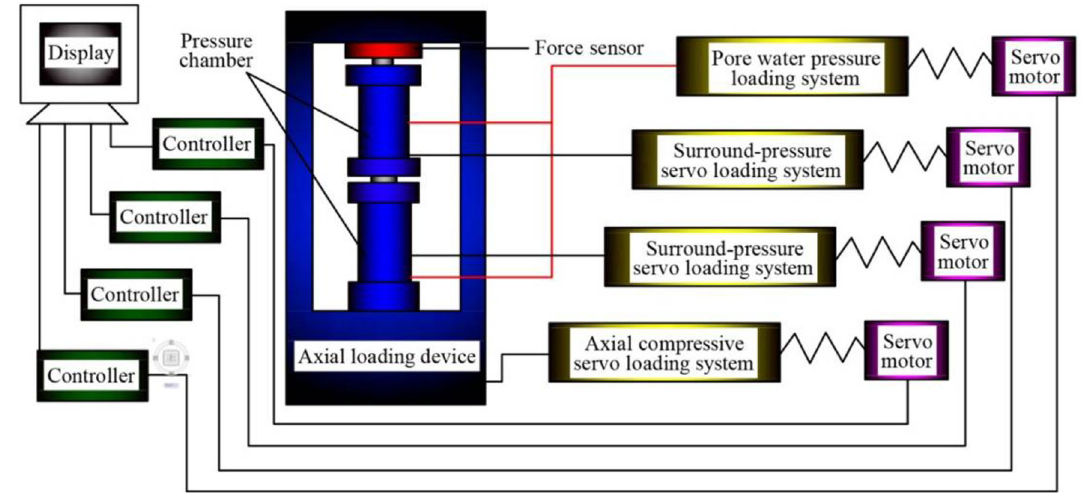
Fig. 6 Schematic diagram of double linkage tri-axial testing machine for hydro-mechanical coupling in soft rock